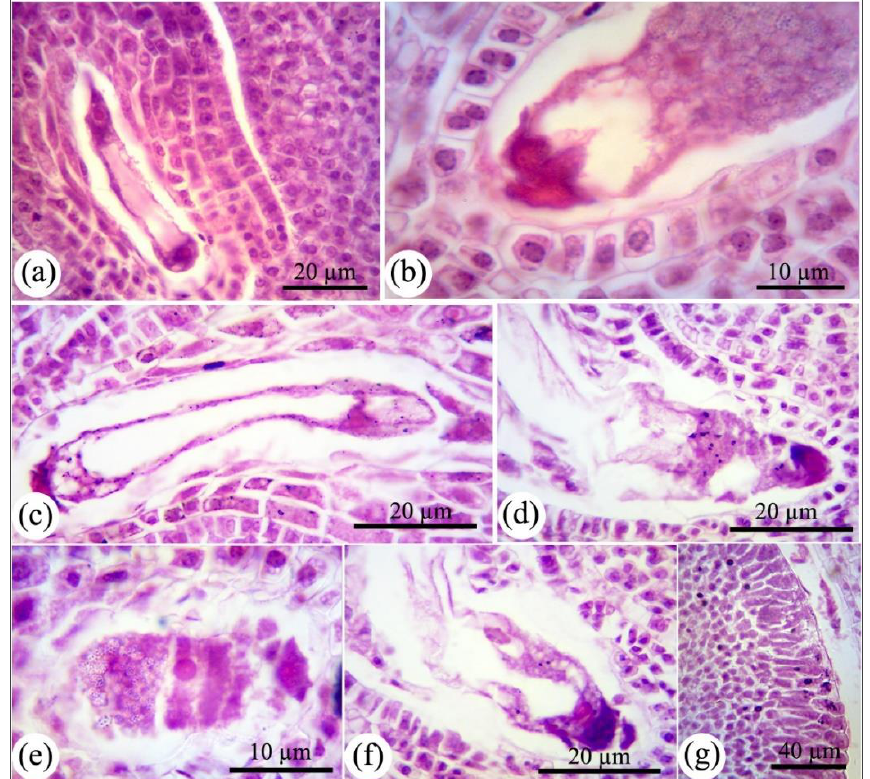
Figure 4. The development of female gametophyte in Phaseolus vulgaris in normal conditions ( a , b ) and treated with nCeO 2 ( c – g ). Accumulation of starch granules inside the embryo sac and maternal tissues is observed after exposure to nCeO 2 ( c ) and ( g ). Apoptosis and fragmentation in nuclei and cytoplasm are also considered important changes in female gametophytes after exposure to nCeO 2 ( d – f ).